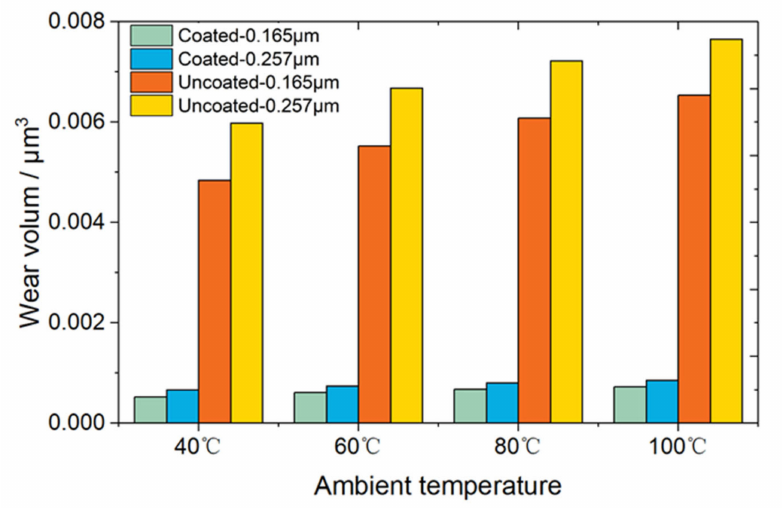
Figure 15. The wear volume for di ff erent surface conditions at various ambient temperatures in a cam cycle under the heavy